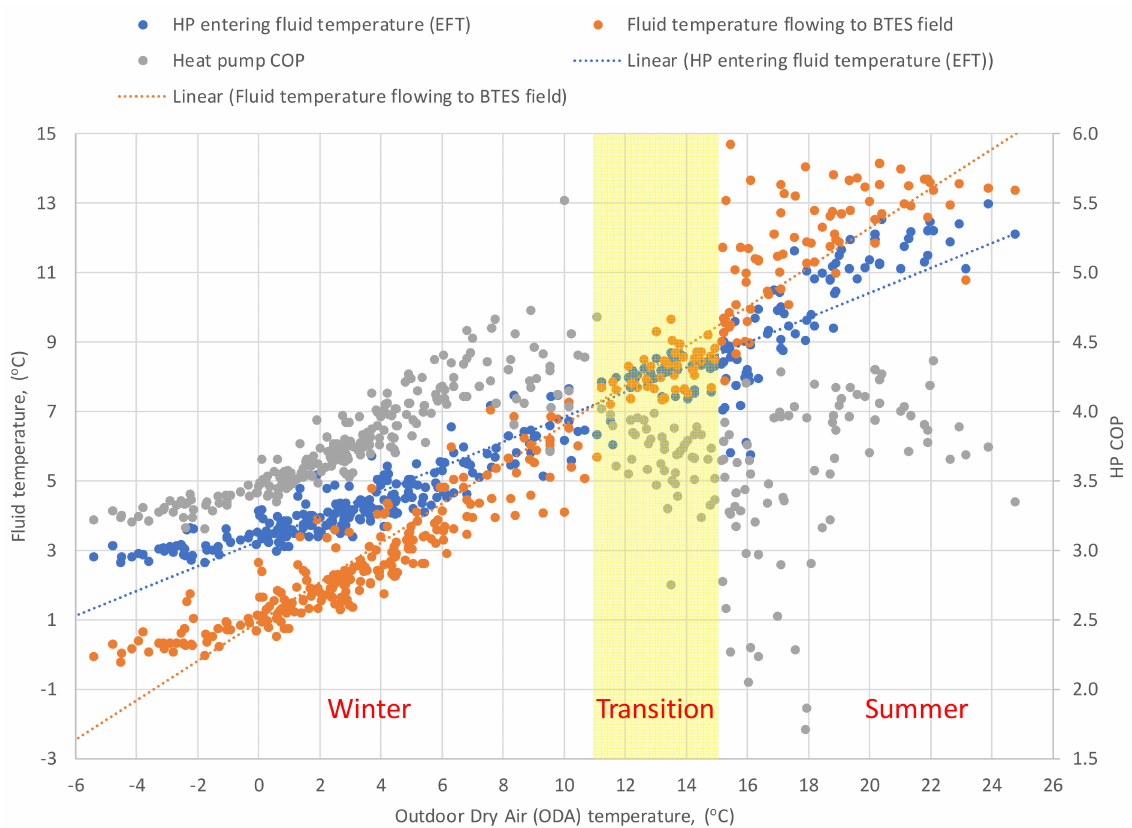
Figure 12. Heat pump’s fluid temperature vs. outdoor dry air temperature (ODA) (average daily